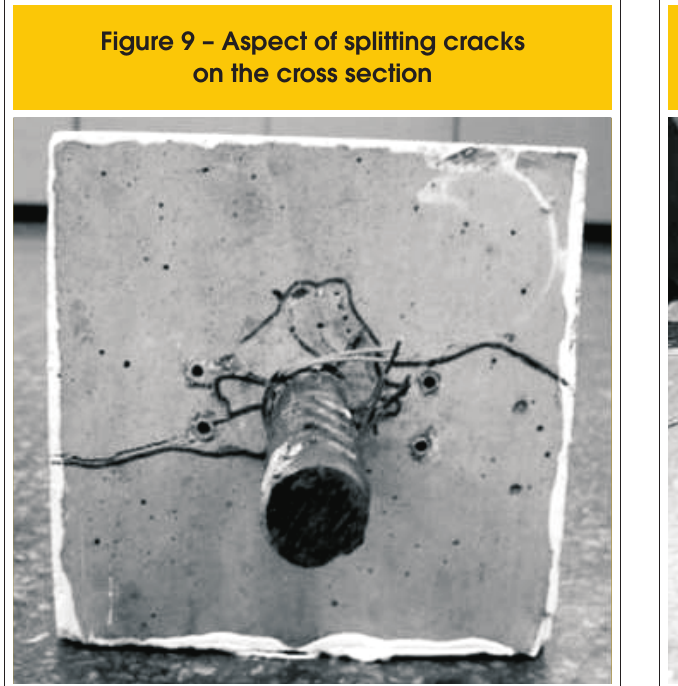
Figure 9 – Aspect of splitting cracks on the cross section